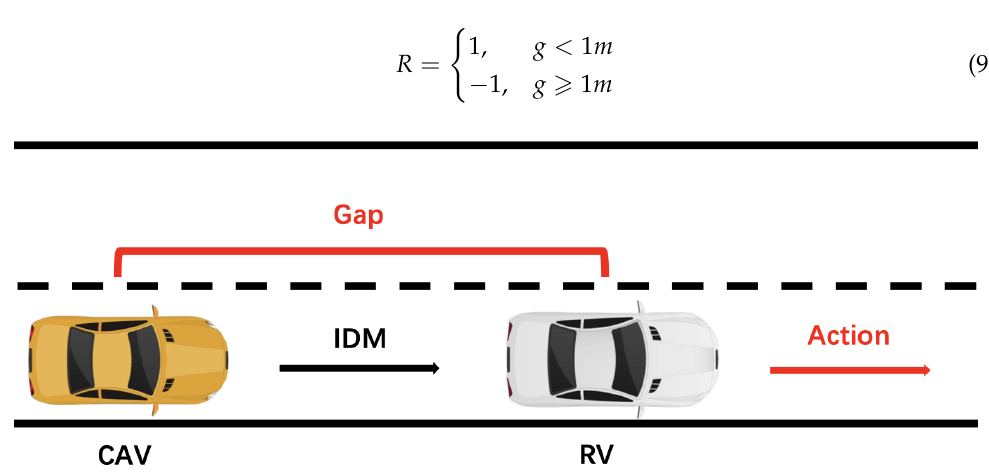
Figure 15. Car-following’s MDP